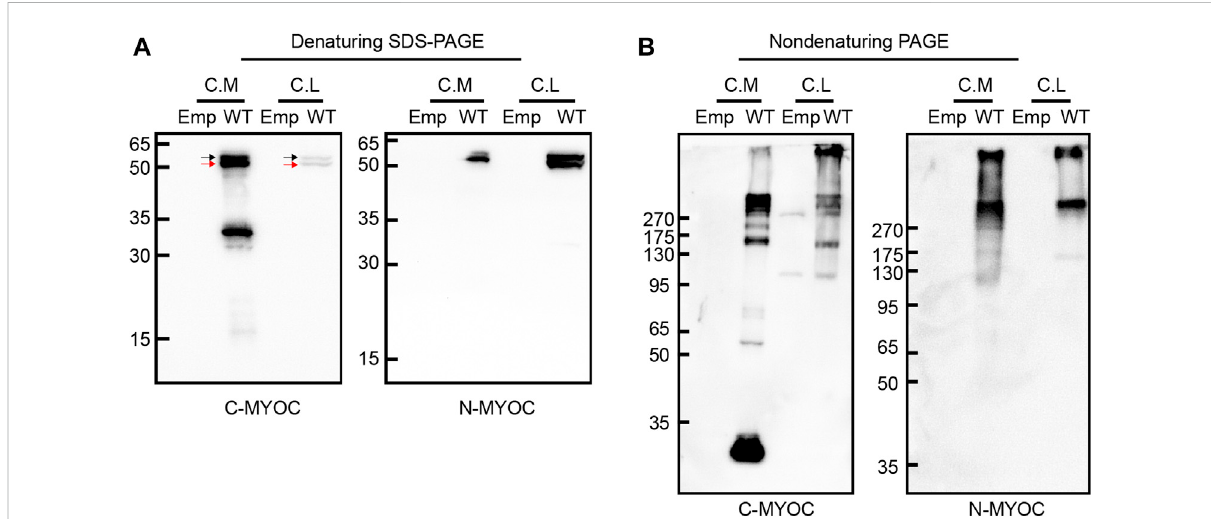
FIGURE 1 Molecular characterization of intracellular and extracellular myocilin. (A,B) A cDNA construct encoding the empty vector (Emp) or wild-type (WT) myocilin was transfected into HEK 293T cells. Forty-eight hours after transfection, myocilin was analyzed in the culture medium (C. M) and cell lysates (C. L) by denaturing SDS – PAGE (A) and nondenaturing PAGE (B) . Myocilin detection was carried out by western blotting using an anti-C- terminal (C-MYOC) or anti-N-terminal (N-MYOC) MYOC antibody. Black arrow: glycosylated myocilin band. Red arrow: